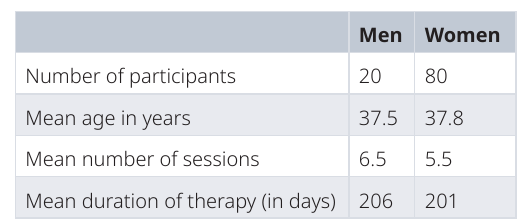
Table 1. Data sample